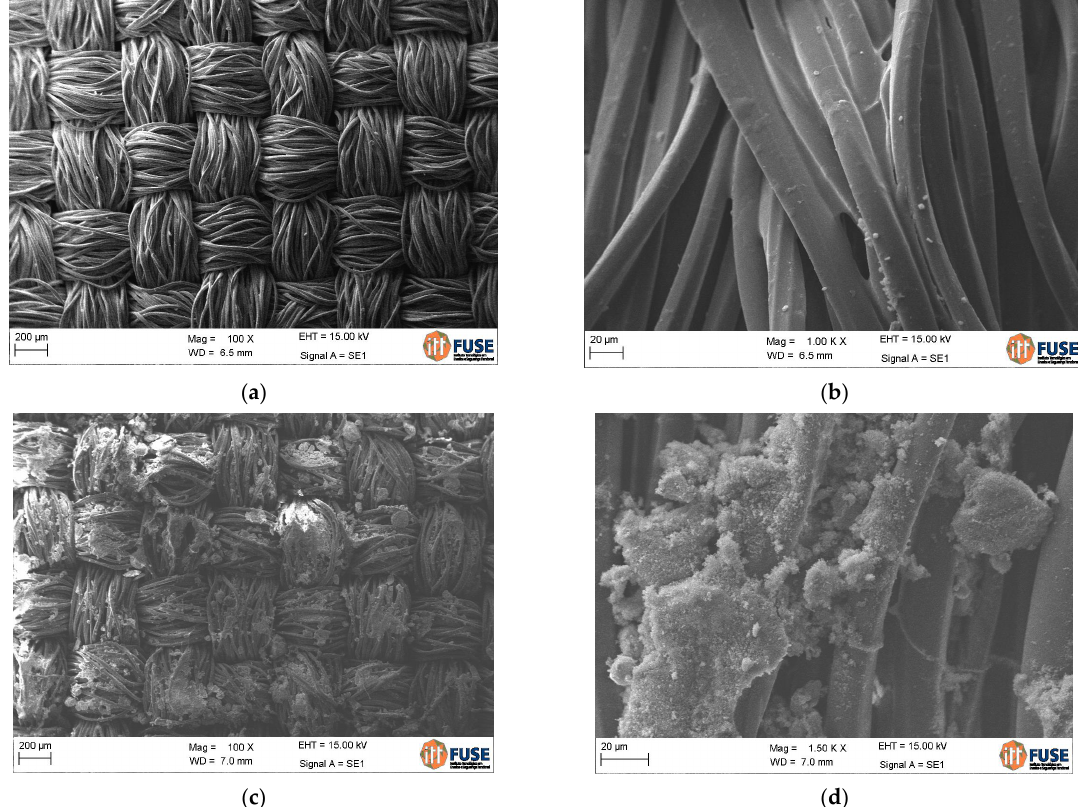
Figure 6. SEM images of: ( a ) untreated polyester textile; ( b ) polyester impregnated with SBR; ( c , d ) polyester impregnated with SBR + SF under different magnifications. ( c , d ) polyester impregnated with SBR + SF under different